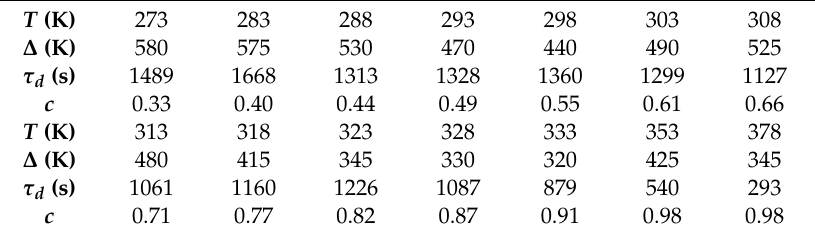
Figure 4. The experimental reduced kinetic curves (points, [2]) of the n -pentane desorption from pellets of NaX zeolite at different temperatures. The solid (red) curves represent the theoretical processing of the data [2] by Equation (13) with parameters ∆ , c , and τ d pointed out in Table 3. Table 3. The results of the theoretical processing of experimental data [2] on the kinetics of n -pentane desorption from pellets of NaX zeolite at different temperatures (Figure 4). The values of the characteristic parameters τ d , ∆ , and c were found by approximating the data [2] according to Equation (13) with the use of the least squares method.